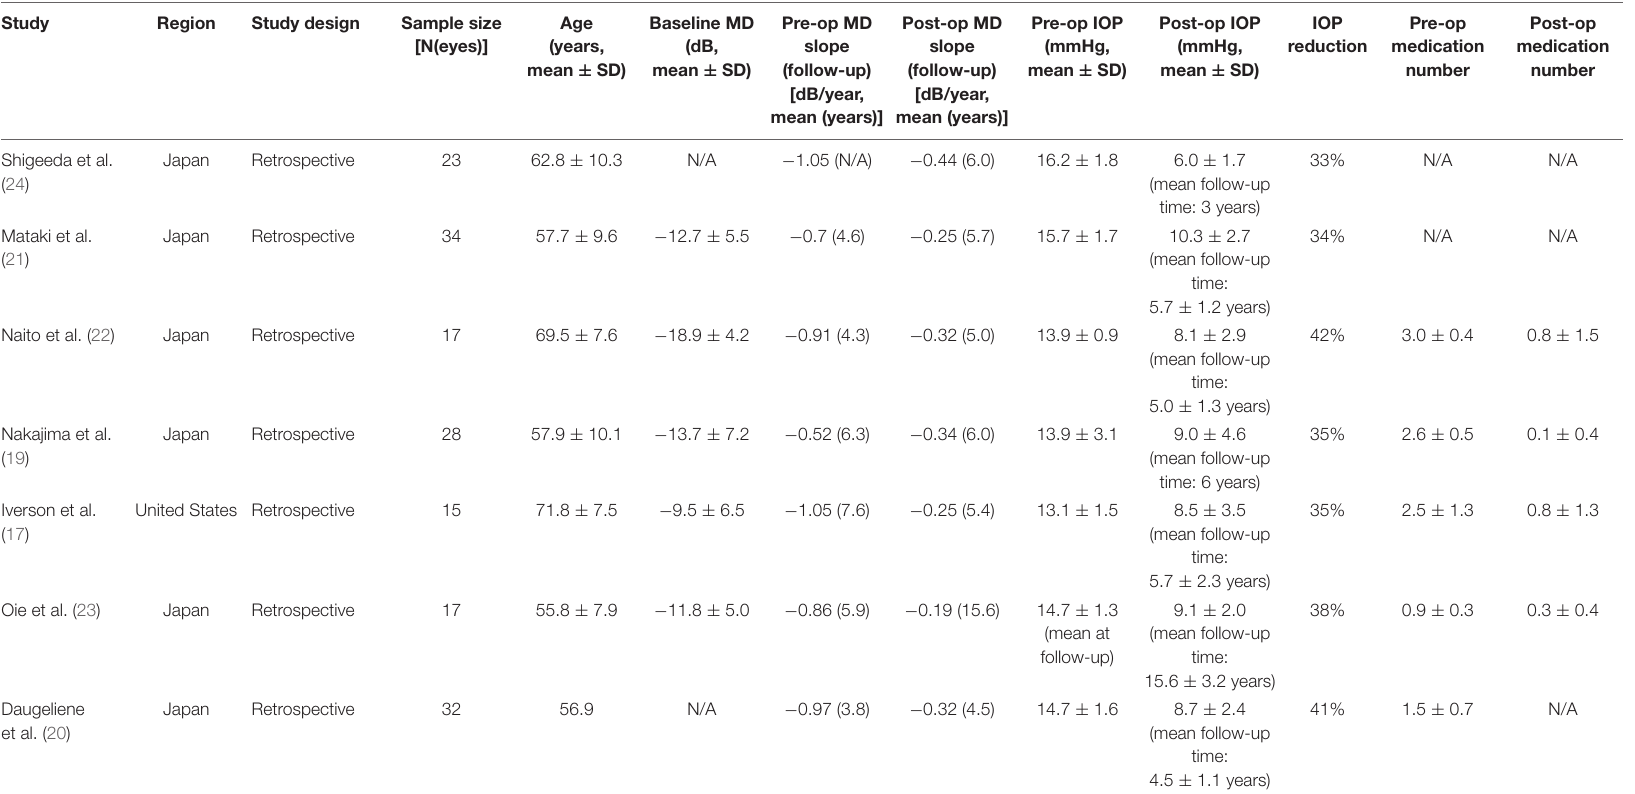
TABLE 1 | Characteristics of included